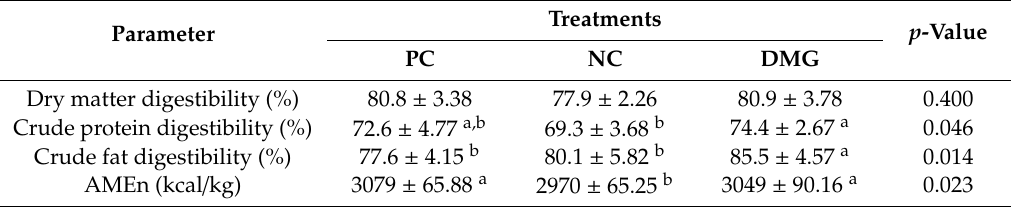
Table 3. Mean values of nutrient digestibility in each experimental group. Parameter